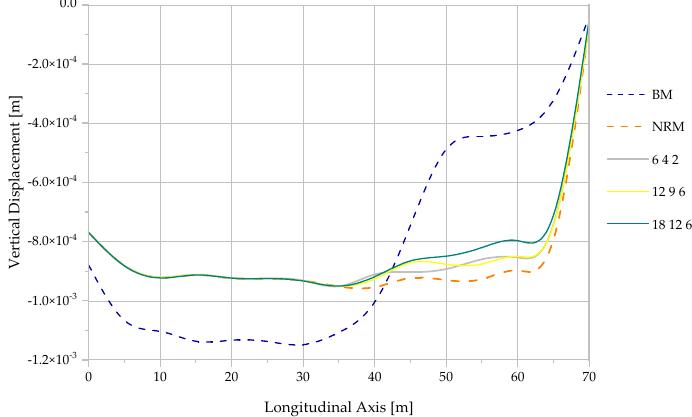
Figure 10. Vertical displacements when implementing the VA.